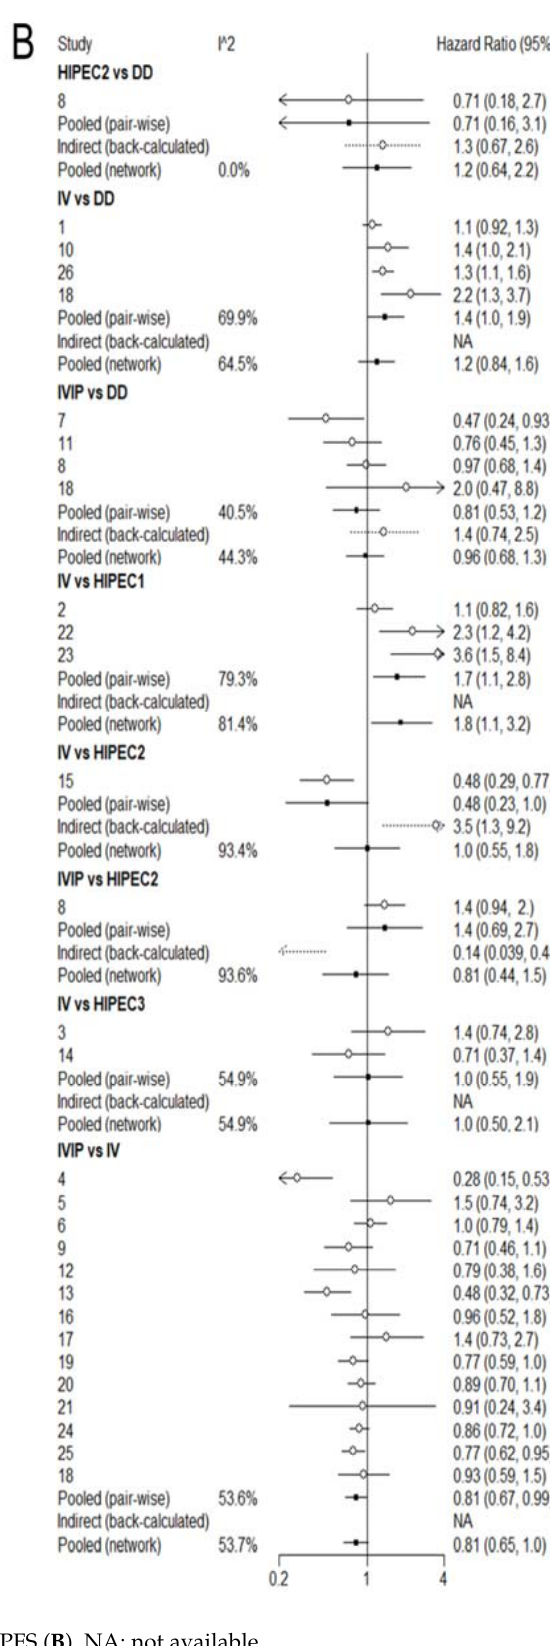
Figure 4. Forest plot of OS ( A ) and PFS ( B ). NA ： not available .